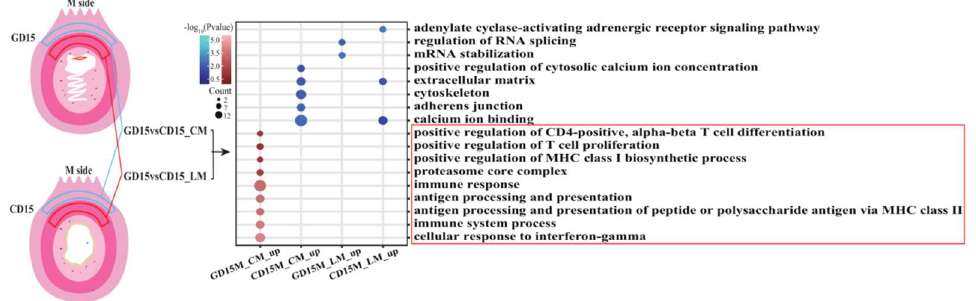
Figure 2. Differences in the transcriptional signatures in M_CM and M_LM between GD15 and CD15 in pigs. GD15, day 15 of pregnancy; CD15, day 15 of the estrous cycle; M, the mesometrial side of the uterus; CM, the circular muscle of myometrium; LM, the longitudinal muscle of myometrium; DEGs, differentially expressed genes.